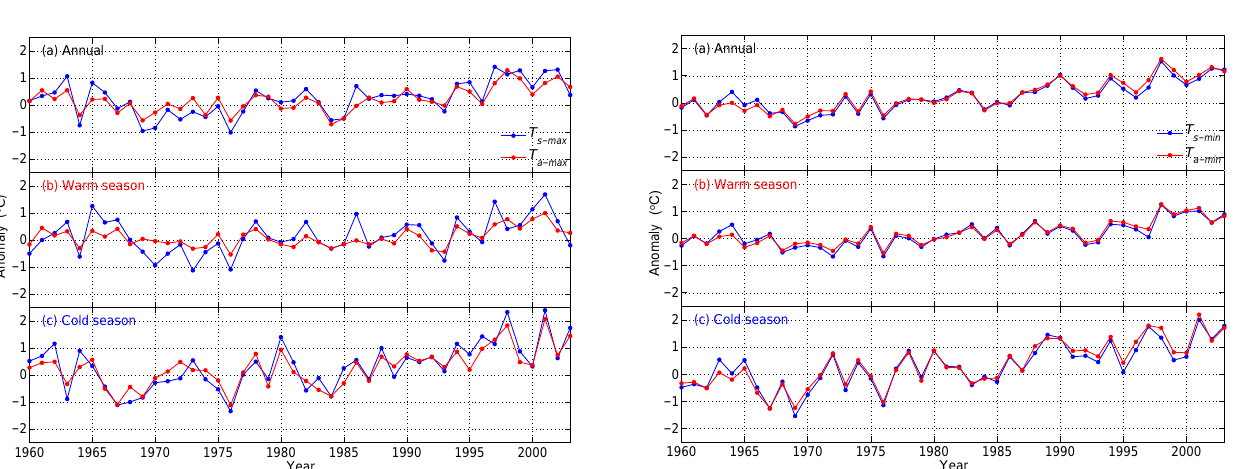
Figure 2. National mean yearly anomalies of daily maximum land surface temperature ( T s-max , blue line) and daily maximum air tem- perature ( T a-max , red line) for the annual (a) , warm (b) , and cold (c) seasonal scales for the reference period from 1961 to 1990.